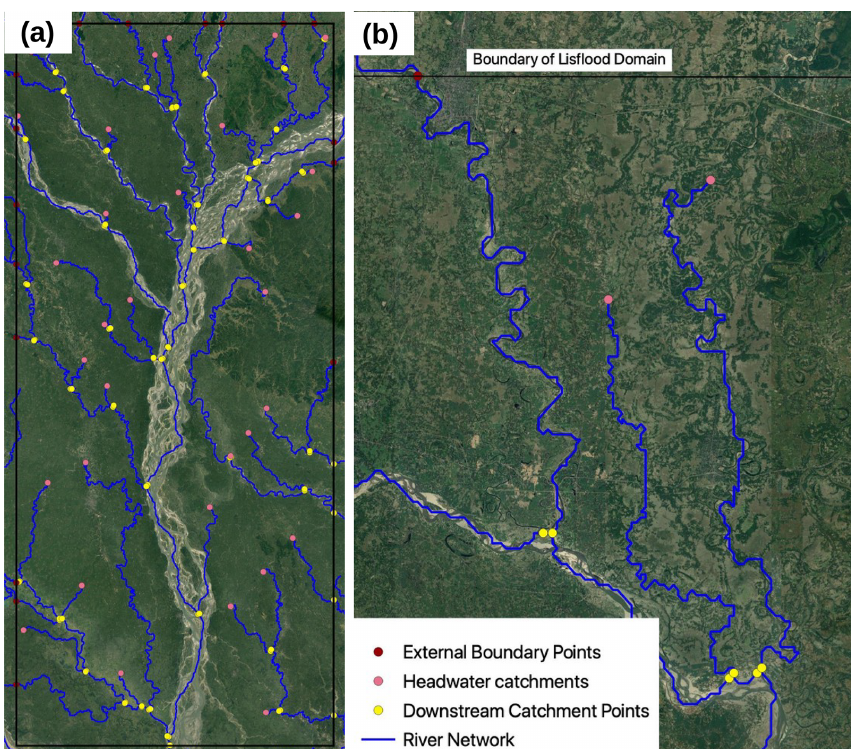
Figure 5. (a) Example of stream network and LISFLOOD-FP input points for the subdomain of the GBM: 89.08–90.3 ◦ E, 24–26.5 ◦ N. (b) Zoomed-in section of this region, showing part of the northern boundary. Map data ©Google Earth 2020.